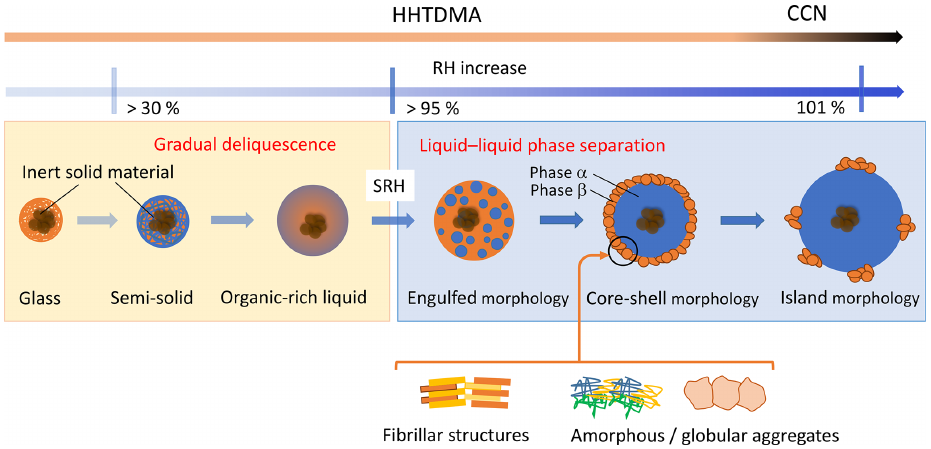
Figure 10. Water uptake by amorphous subpollen particles: possible morphology and processes. SRH is the RH onset of liquid–liquid phase